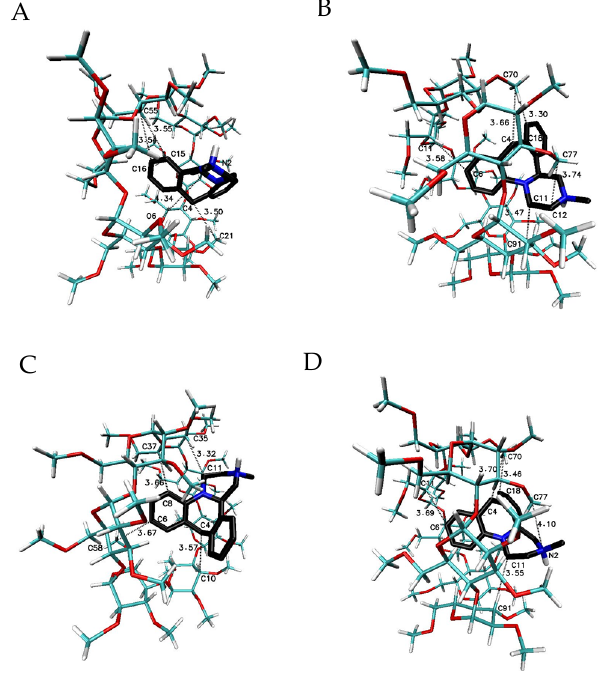
Figure 9. The chosen geometries of the MIA–TM β -CD complex with stoichiometry 1:1 (I for ( A , C ) and II for ( B , D ) obtained by MD simulations with the use of TM β -CD crystal structure with refcode ALIGAE from the CSD data base [39]; ( A , B ) for S-(+)-MIA ∙ HCl and ( C , D ) for R-( − )-MIA ∙ HCl.